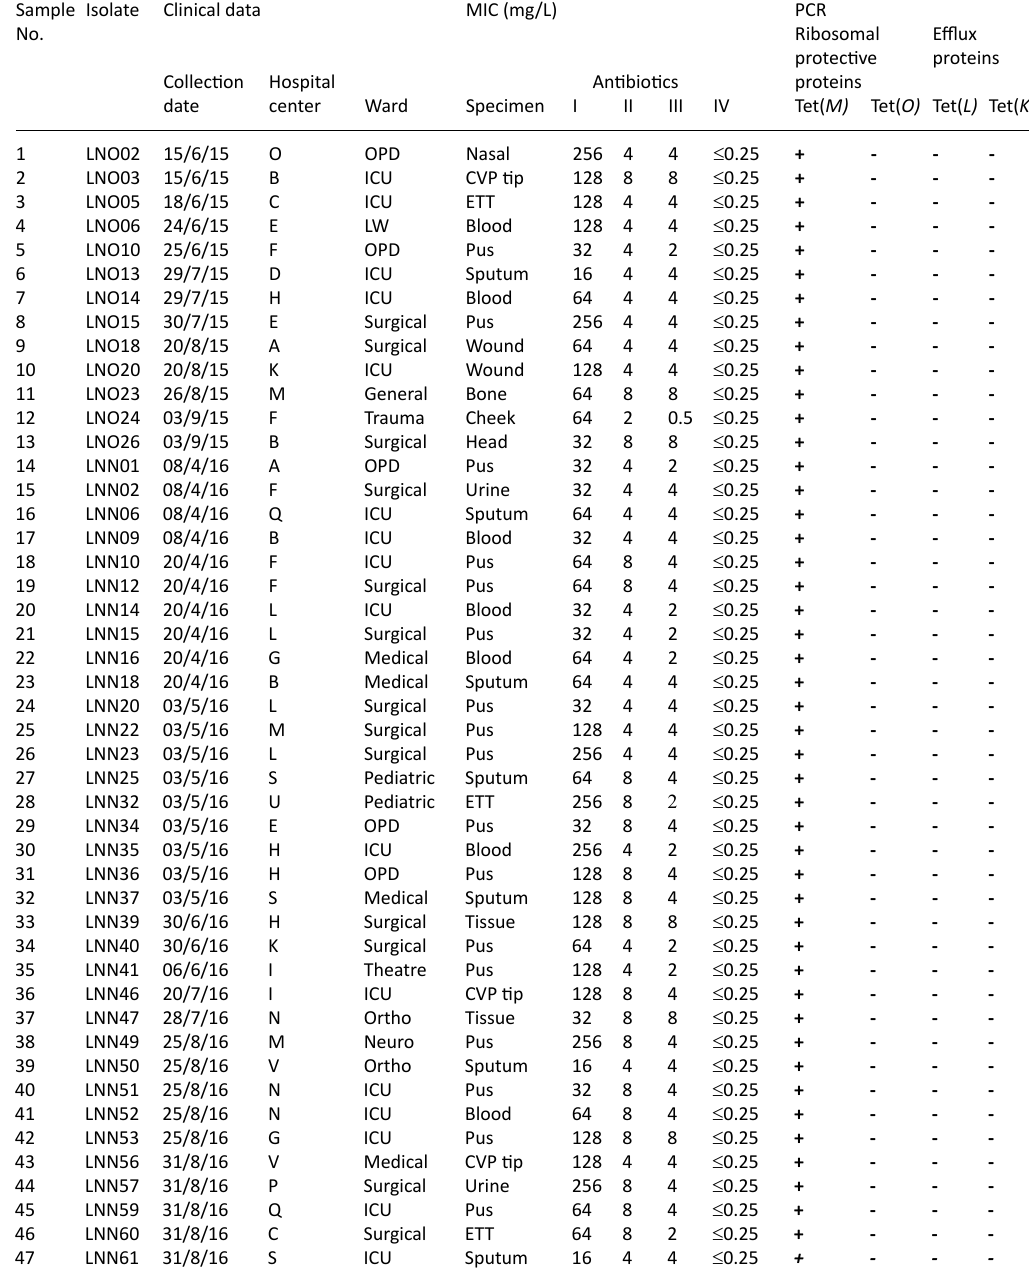
table 1. Clinical data, minimum inhibitory concentrations (MIC), and results of PCR for 47 tetracycline resistant MRSA isolates Sample Isolate Clinical data